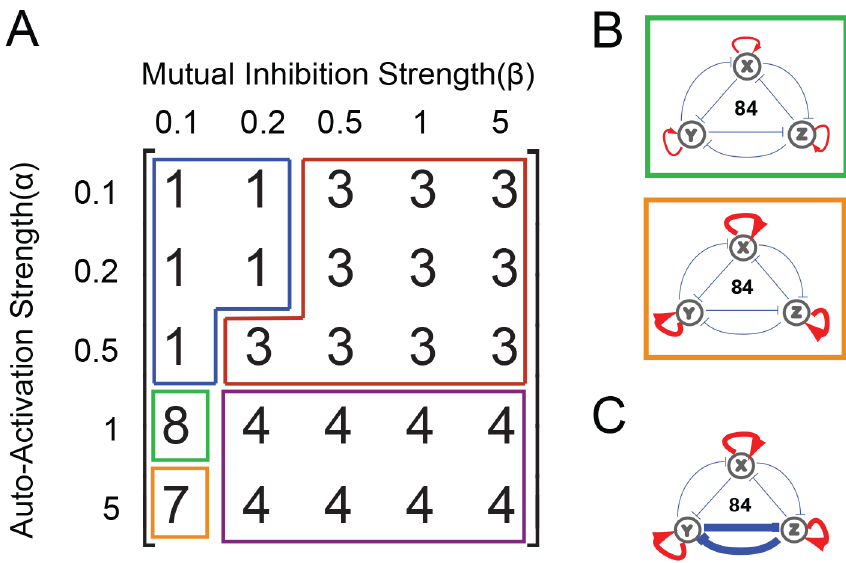
Figure 4. Stable Steady State Analysis of Network 84. (A) A matrix presenting the number of stable steady states generated by combinations of different auto-regulatory strengths (rows) and mutual-regulatory strengths (columns). This provides an overview of network stability at various points in the parameter regulation space; the green and orange regions are visualized as FCT diagrams independently in B. (B) The green-boxed diagram corresponds to the green-boxed parameter combination regime from (A), where genes have regulatory strengths a =1 and b =0.1. By contrast, the orange-boxed diagram corresponds to the orange-boxed parameter combination regime from (A), where nodes have regulatory strengths a =5 and b =0.1. This parameter combination regime allows the system to be stable in 7 of the 8 SSS, losing only the all-OFF state. (C) Many of the parameter combinations yielding multi-stable systems are not represented by the matrix, and are instead abstracted here. As an example, here we present a parameter combination regime that can support 6 SSS and auto-activation strengths are similar to those in the orange box (thick red arrows) but have one unrestrained pair of mutual inhibition that can exist at a very high strength (blue T-head repression lines).